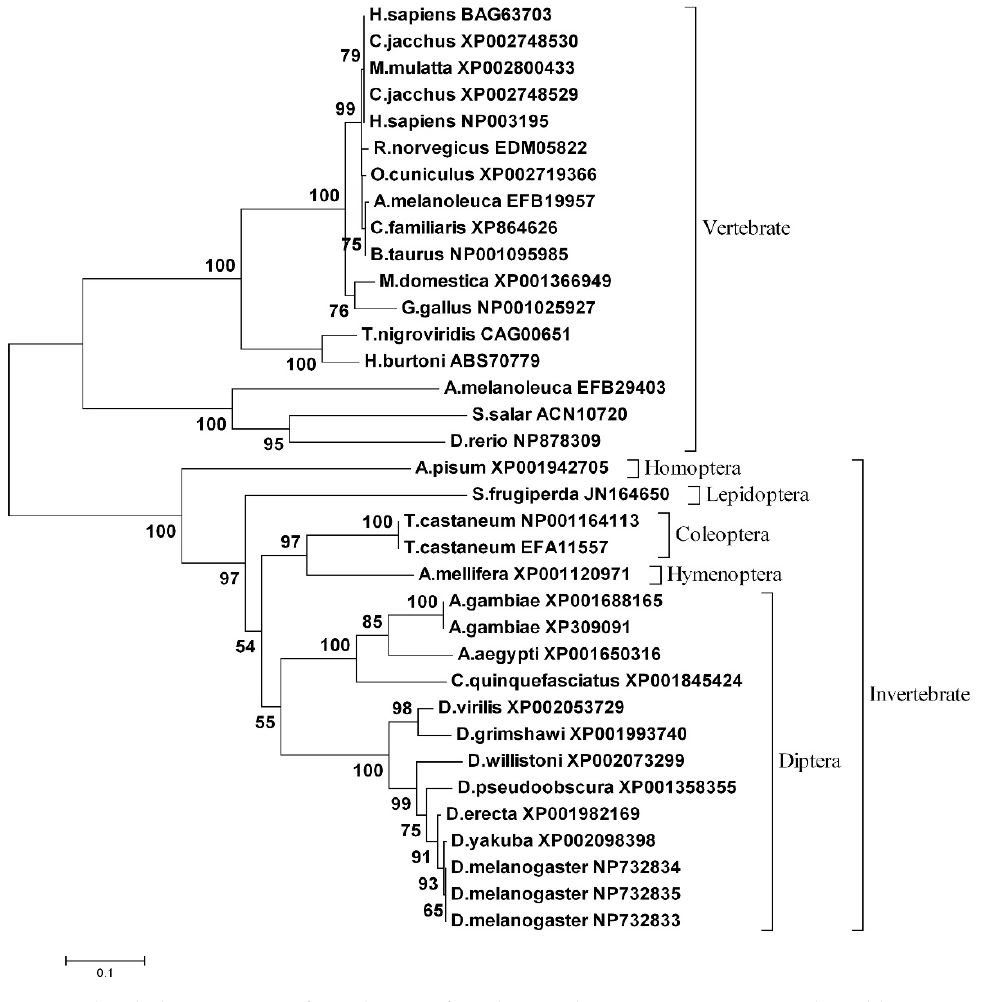
Figure 2. The phylogenetic tree of vertebrate Nrf2 and invertebrate CncC. A non-rooted neighbor-joining tree using Poisson-correction (Bootstrap values: 1000 replicates) distances was constructed with CncC/Nrf2 ORF amino acid sequences of vertebrate and invertebrate species from Acyrthosiphon pisum , Aedes aegypti , Ailuropoda melanoleuca , Anopheles gambiae , Apis mellifera , Bos taurus , Callithrix jacchus , Canis familiaris , Culex quinquefasciatus , Danio rerio , Drosophila erecta , Drosophila grimshawi , Drosophila melanogaster , Drosophila pseudoobscura , Drosophila virilis , Drosophila willistoni , Drosophila yakuba , Gallus gallus , Haplochromis burtoni , Homo sapiens , Macaca mulatta , Monodelphis domestica , Oryctolagus cuniculus , Rattus norvegicus , Salmo salar , Tetraodon nigroviridis , Tribolium castaneum , and Spodoptera frugiperda . Genbank accession numbers were given in this figure.